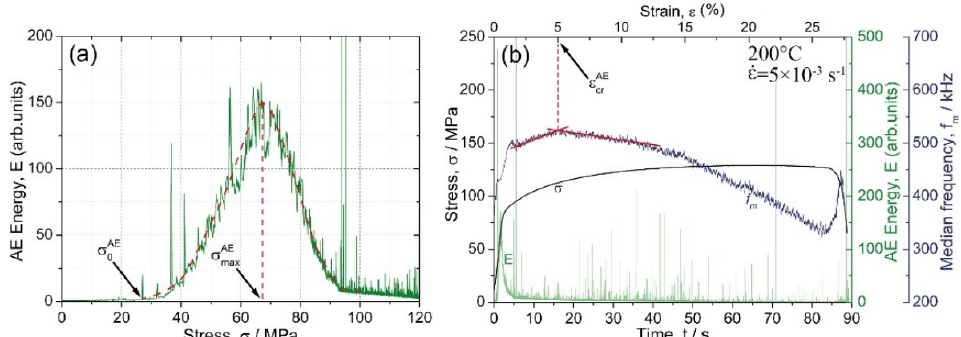
Figure 8. Schematic of determining the AE characteristics using the example of testing results obtained at 200 °C and ε = 5 × 10 − 3 s − 1 ; ( a ) stress corresponding to the onset of AE σ AE 0 (AE elastic limit), and stress corresponding to the AE peak σ AE max (AE yield stress); ( b ) critical strain ε AE cr corresponding to the breakpoint in the f m